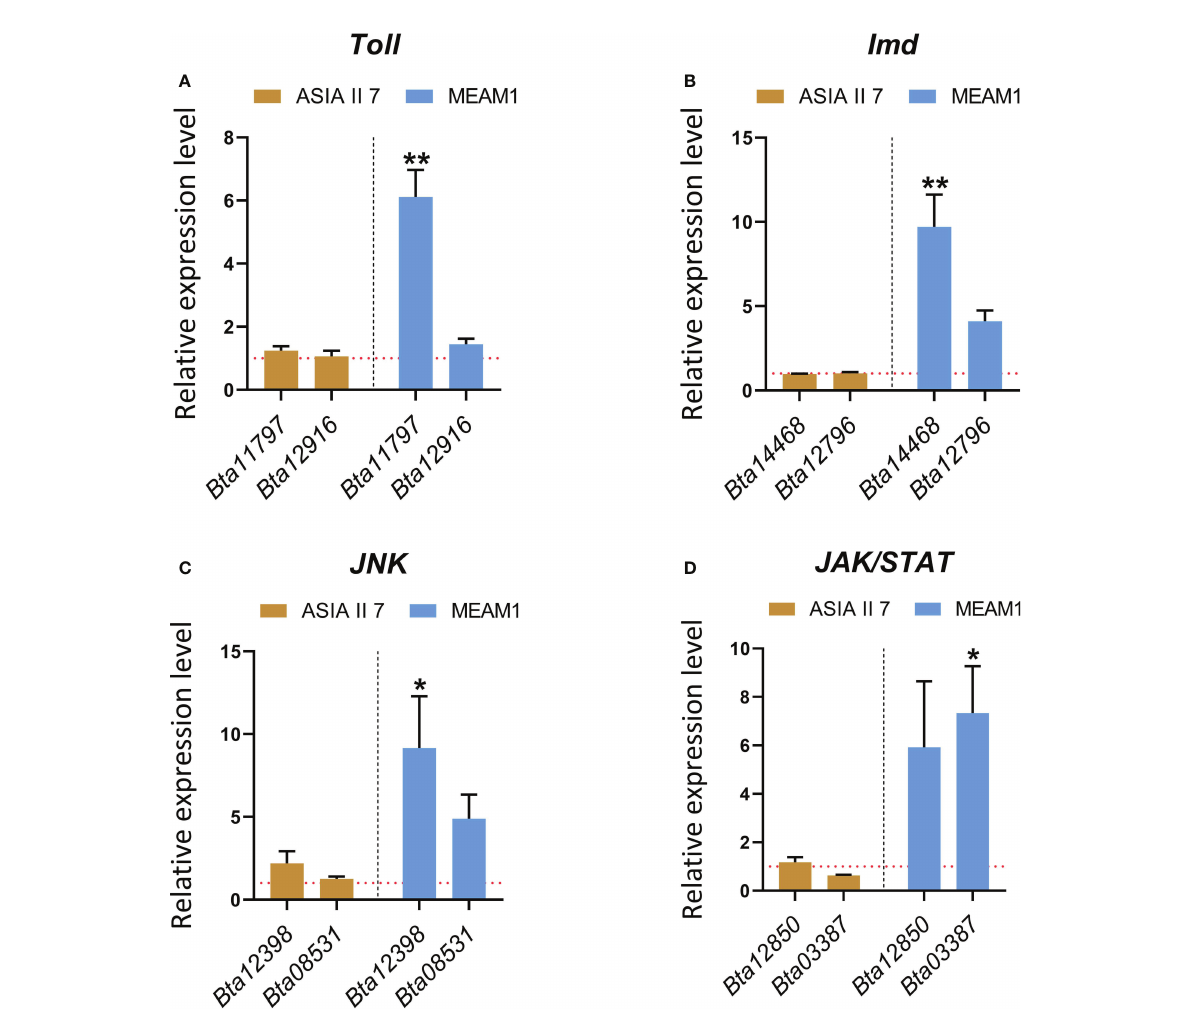
FIGURE 7 Comparative transcriptional response of white fl y genes involved in the antiviral immune signaling pathways. White fl ies (Asia II 7 & MEAM1 cryptic species) were allowed to feed on the virus source for 48 hours followed by RNA extraction and RT-qPCR based quanti fi cation of the genes involved in (A) Toll (B) Imd (C) Jnk and (D) Jak / STAT antiviral immunity-related pathways. Differences between treatments were analyzed by independent t -test and the statistical signi fi cance was de fi ned as: * P < 0.05 and ** P < 0.01. Horizontal dotted lines (red) denote the relative mRNA expression levels of the target genes in healthy (aviruliferous) white fl